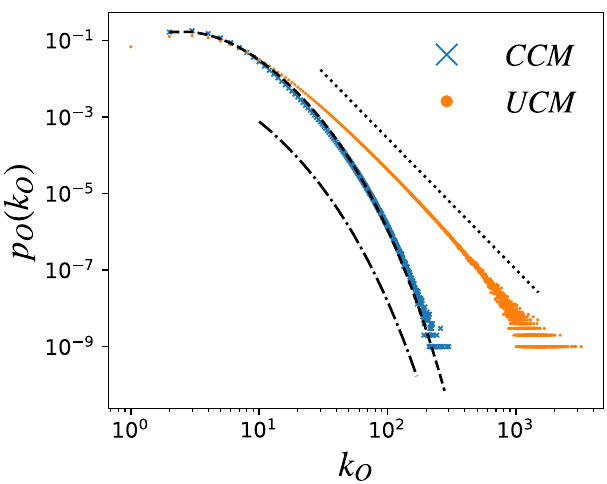
Fig. 2 The degree distributions for the correlated copying model (CCM) and uniform copying model (UCM). Degree probability, p O ( k O ), plotted as a function of the observed degree, k O . UCM initialised with copying probability p = 0.374 (equal to the CCM ’ s effective copying probability). Networks grown to t = 10 7 , averaged over 100 networks. Error bars omitted for clarity. Dashed line: analytical expression for CCM in Eq. (14). Dot- dashed: stretched exponential approximation. Dotted: power-law